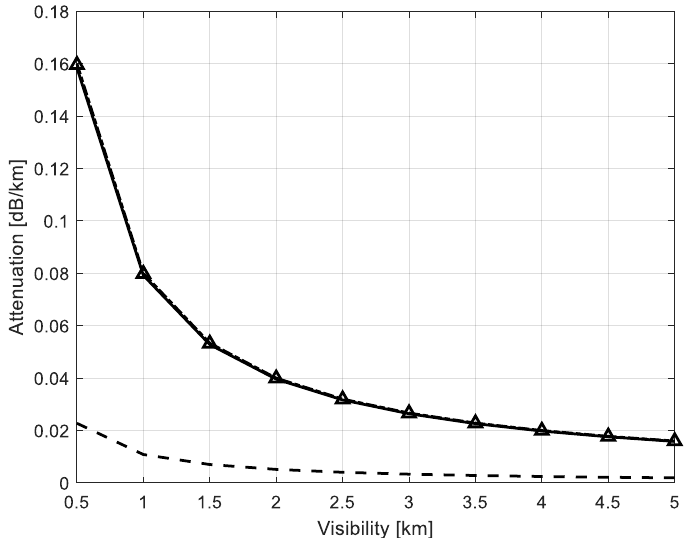
Figure 5. Comparison of specific attenuation due to dust storm for different values of visibility at 40 GHz; Goldhirsh [10] Equation (9) — dashed line ( ‒ ‒ ), Elabdin et al. [13] — solid line ( ― ), Ali et al. [11] Equation (12) — triangles ( ∆ ), proposed solution by Equations (1), (8), (14) and (16).